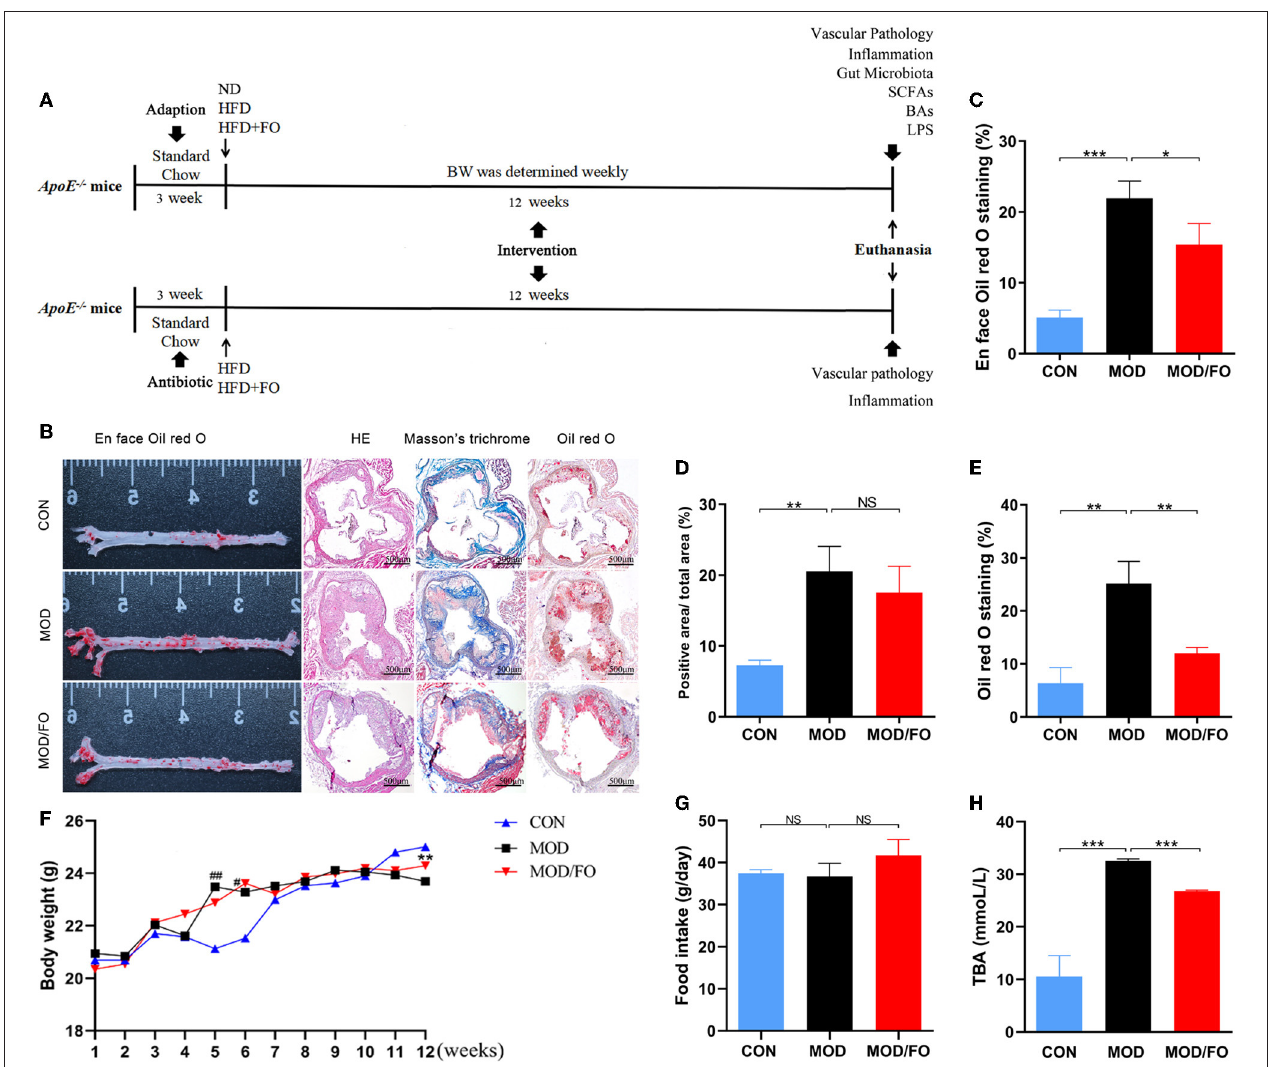
FIGURE 1 | Effects of dietary ALA-rich FO treatment on the pathological lesion and routine parameters in atherosclerotic ApoE − / − mice. (A) Schematic time diagram of the experimental design. (B) Representative stained sections of the valve area of the aorta and aortic root of the heart. Quantitative analysis as lesion area/total area (%) shown in en face oil-red O staining ( n = 5/group) (C) , Masson’s trichrome staining (D) , and oil-red O staining (E) . (F) BWs: Body weights. (G) Food intake. (H) TBA: total bile acid. Original magnification, × 40. The bar of 500 µ m was presented in the right corner of (B) . Data were presented as mean ± SEM. # P < 0.05, ## P < 0.01, CON group vs. MOD group. * P < 0.05, ** P < 0.01, *** P < 0.001, MOD group vs. MOD/FO group. NS, no